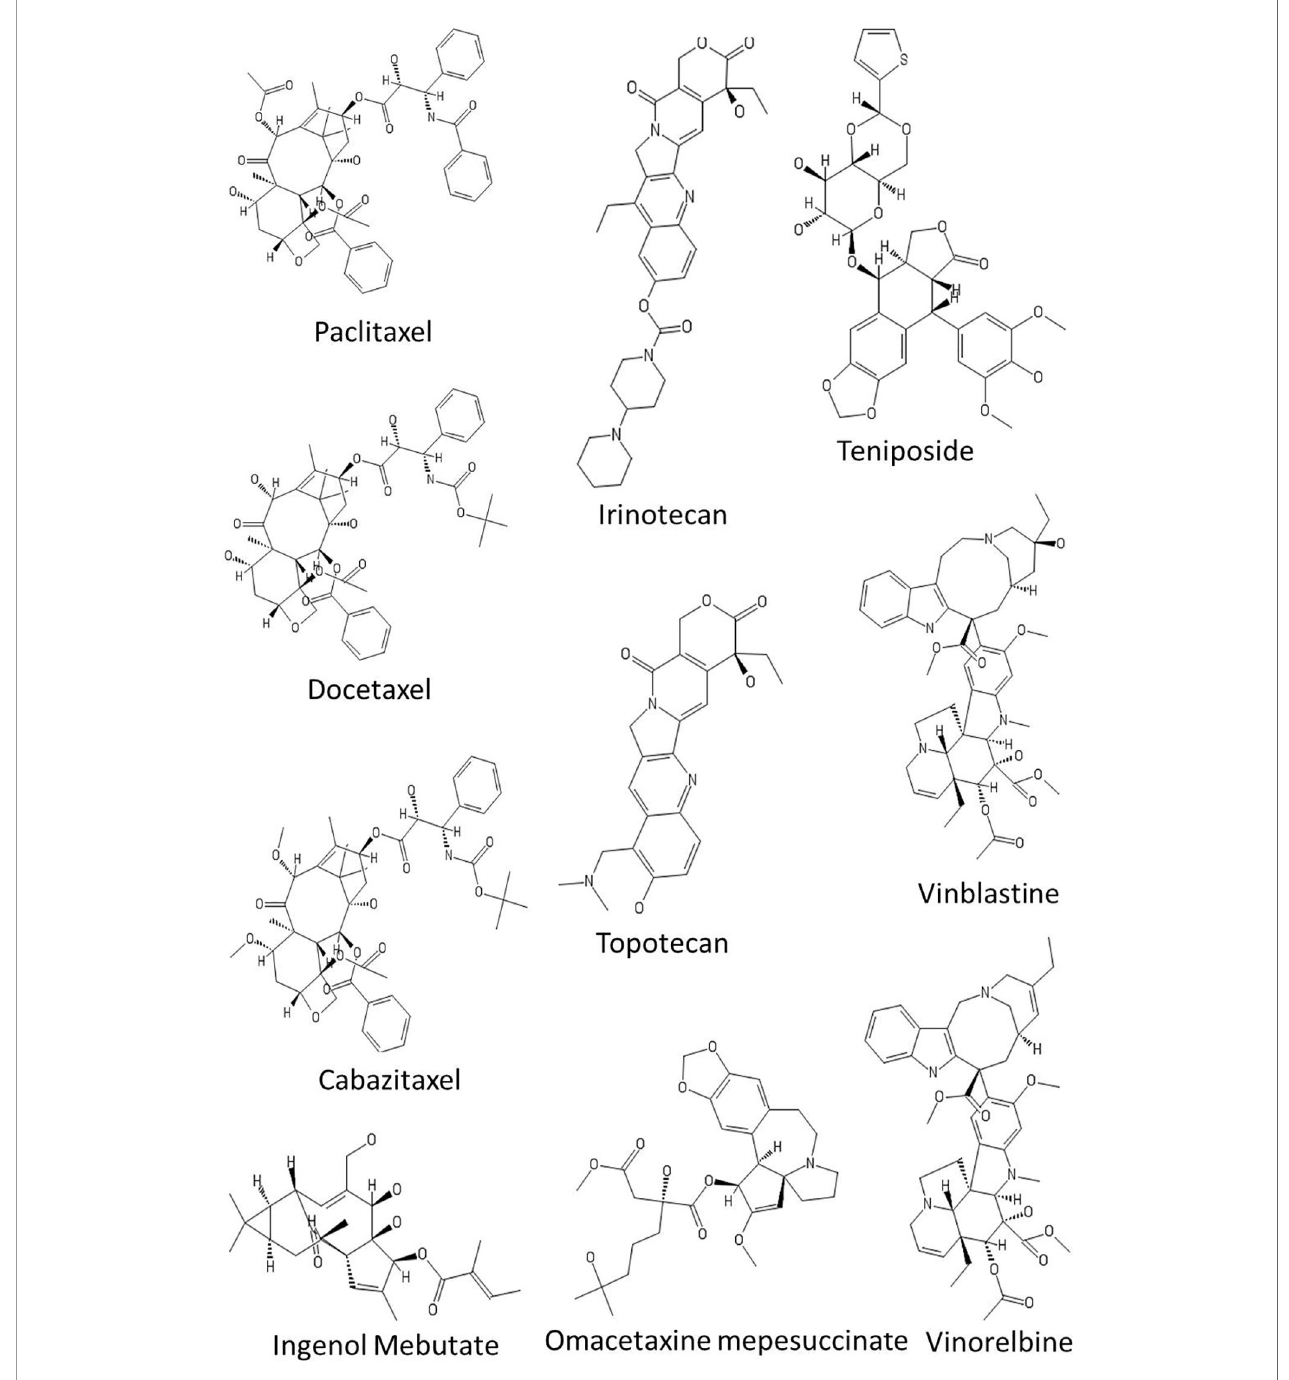
FIGURE 3 | Chemical structures of some anticancer agents in clinical